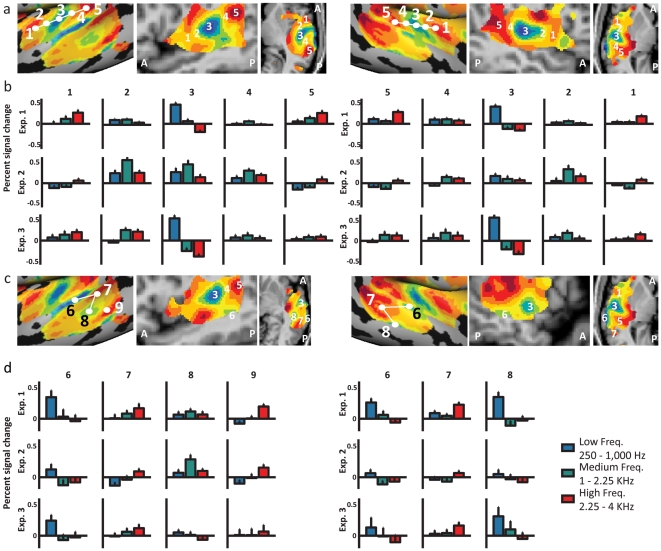
Cochleotopic maps in the human auditory cortex verified by RFX-GLM raw time-course analysis.
A. Auditory cortex relative frequency preference map magnification is the same as in
Figs. 2

 and

3
, with points (1–5, see Talairach coordinates at
Table 1
) along the auditory core gradients that were used to sample individual time-courses and compute random effect GLM time-course analysis. The approximate location of the same sampling points is also presented in a volume view of sagittal and horizontal slices. B. Time-courses of activation and response averages were sampled from points (1–5) along the anterior-posterior cochleotopic gradient (of the core areas), in both cortical hemispheres. Response averages were calculated for Exp. 1 group (n = 10), Exp. 2 group (falling chirp, n = 5) and for Exp. 3 group (scan repetition, n = 4) from the same locations. The continuous auditory stimulation was analyzed by dividing it in a random effect general linear model (RFX-GLM) into low, medium and high frequency tone conditions. Error bars denote standard error of the mean (SEM). Tone preference examined using this complementary analysis was consistent with relative frequency preference maps revealed by spectral analysis. C. Auditory cortex relative frequency preference map magnification is the same as in
Figs. 2

 and

3
, with points (6–9) marking the lowest and highest frequency tones which represent the mirror-symmetry flipping points between the extra-core cochleotopic maps (see Talairach coordinates at
Table 1
). These points were used to sample individual time-courses and compute random effect GLM time-course analysis, similarly to A-B. The approximate location of the same sampling points is also presented in a volume view of sagittal and horizontal slices, with reference to the sampling points of the core. D. Similar to B, response averages of activation were sampled from points 6–9 in the left hemisphere, and 6–8 in the right hemisphere, along the superior-inferior cochleotopic gradient in both scan sessions, validating the tone preference of the iso-frequency bands in the extra-core areas of auditory cortex.